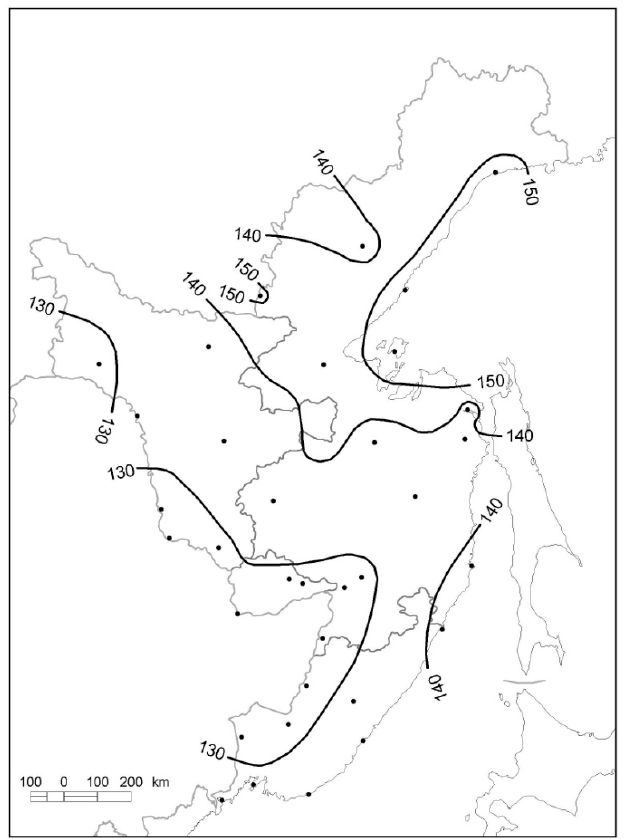
Figure 8. Dependence of Sensitivity Index for growing degree days with 15 °C threshold (GDD15SI) and its standard deviation (SD) for a GDD15 +3 scenario on altitude and latitude for maritime locations in the Russian Far East for the period 1966–2017: ( A , B ) altitude (m), ( C , D ) latitude.